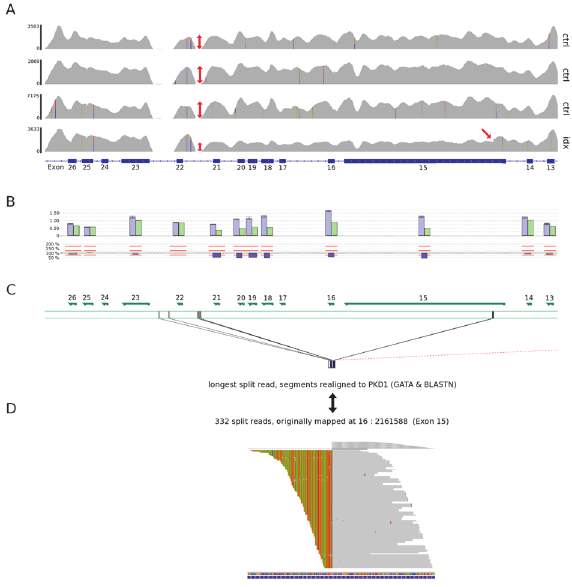
Fig 3. CNV detection of multiple exon deletion in PKD1 for patient 46 with breakpoint analysis. A Coverage plots (IGV) of three control (ctrl) patients versus the index (idx) sample illustrate the statictical readout with a drop in coverage at PKD1 exons 15 – 21 for the index (red double arrows) compared to controls indicating a deletion event at this position. Correspondingly, a within-sample decrease in coverage to surrounding exons can be observed in the index patient. The 5 ’ decrease in coverage is located at a clear-cut position at the beginning of exon 15 (red arrow). The PKD1 gene is displayed from the right to the left. B Result from MLPA analysis displayed by MLPA module in JSI SeqPilot software showing the deletion of exons 15 – 21 in PKD1 . The relative peak area (RPA) of the patient result file (green) and of the control result file (blue) with standard deviation (error bar) is shown. Ratio RPA was calculated as RPA of the patient versus controls. Deletions are indicated if the ratio RPA falls below 75%. C and D Evaluation of the exact breakpoint of the deletion using split reads. Initially, the ClipCrop tool identified an occurrence of excess split reads in exon 15, here visualized using IGV (D). The soft-clipped (unaligned) part of split reads was further inspected in part (C) by application of general motif search tools (GATA and BLASTN algorithm). The highest-scoring alignment within PKD1 was found in the repeat-rich intronic region between exons 21 and 22, therefore representing the most likely 3 ’ deletion breakpoint. This repeat-rich region escapes sequence capture and probably represents a hotspot for chromosomal